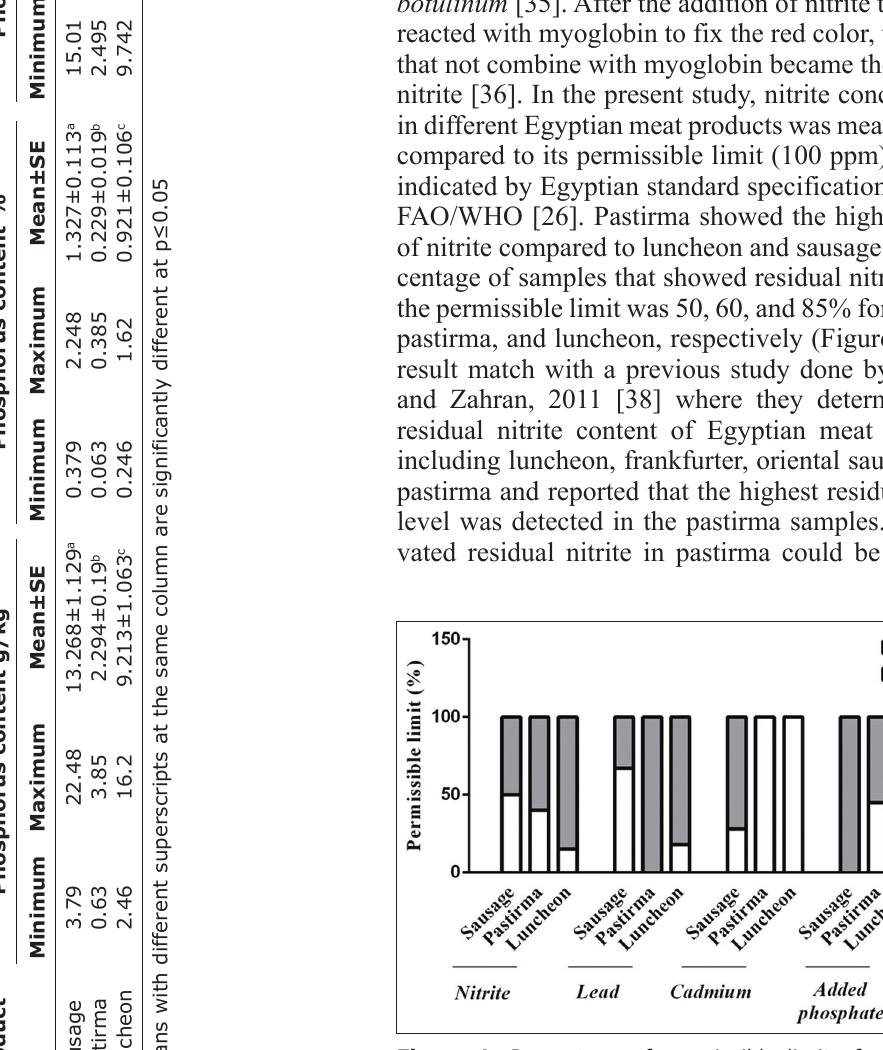
Figure-1: Percentage of permissible limit of some meat contaminants in different Egyptian meat